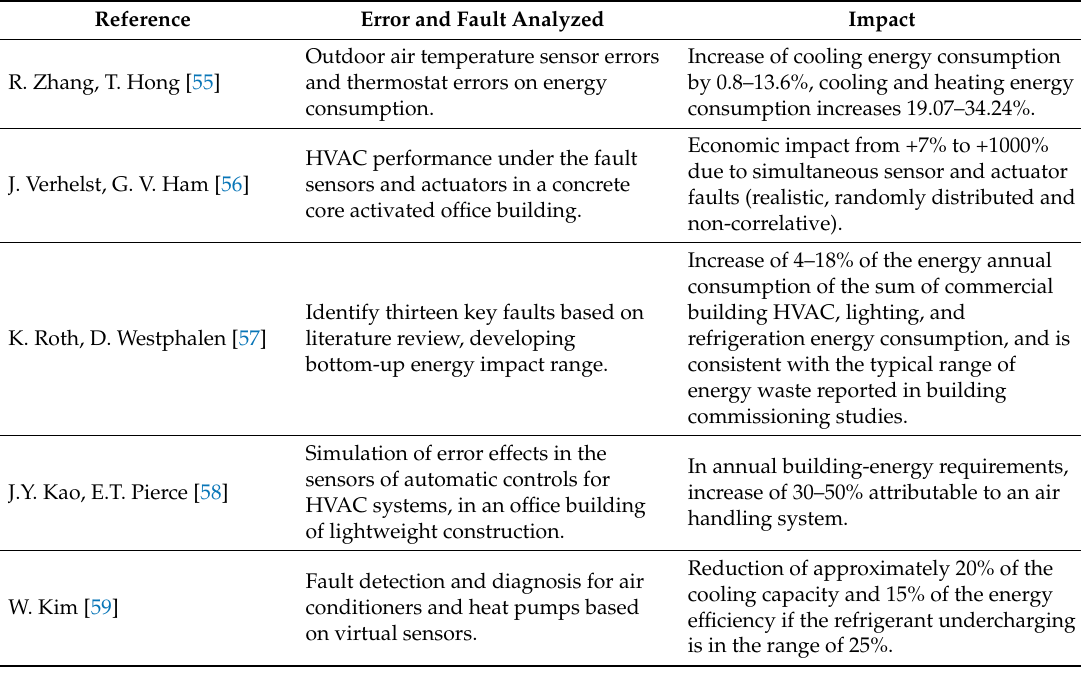
Table 3. Examples of impacts produced by sensor errors in some study